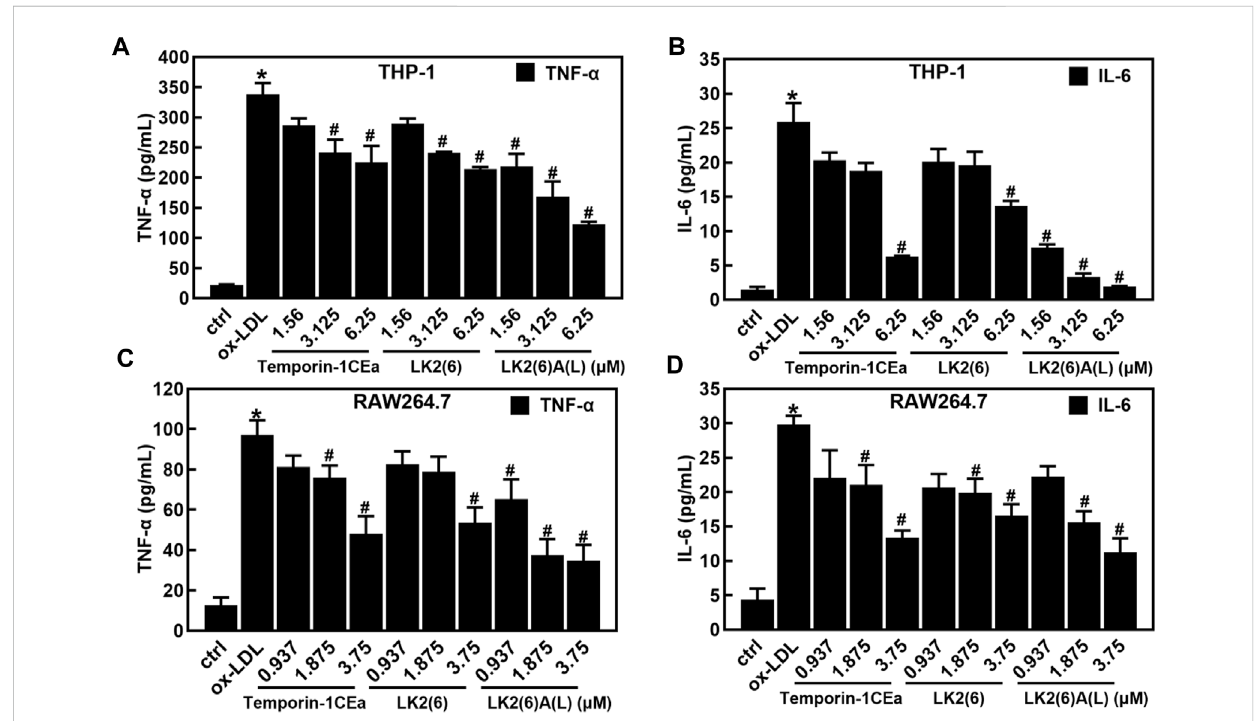
FIGURE 4 Effects of frog skin AMPs on the in fl ammatory response in ox-LDL induced foam cells. Levels of TNF- α and IL-6 in foaming THP-1 cells (A,B) ; Levels of TNF- α and IL-6 in foaming RAW264.7 cells (C,D) . * p < 0.05 vs. the ctrl group. # p < 0.05 vs. the ox-LDL